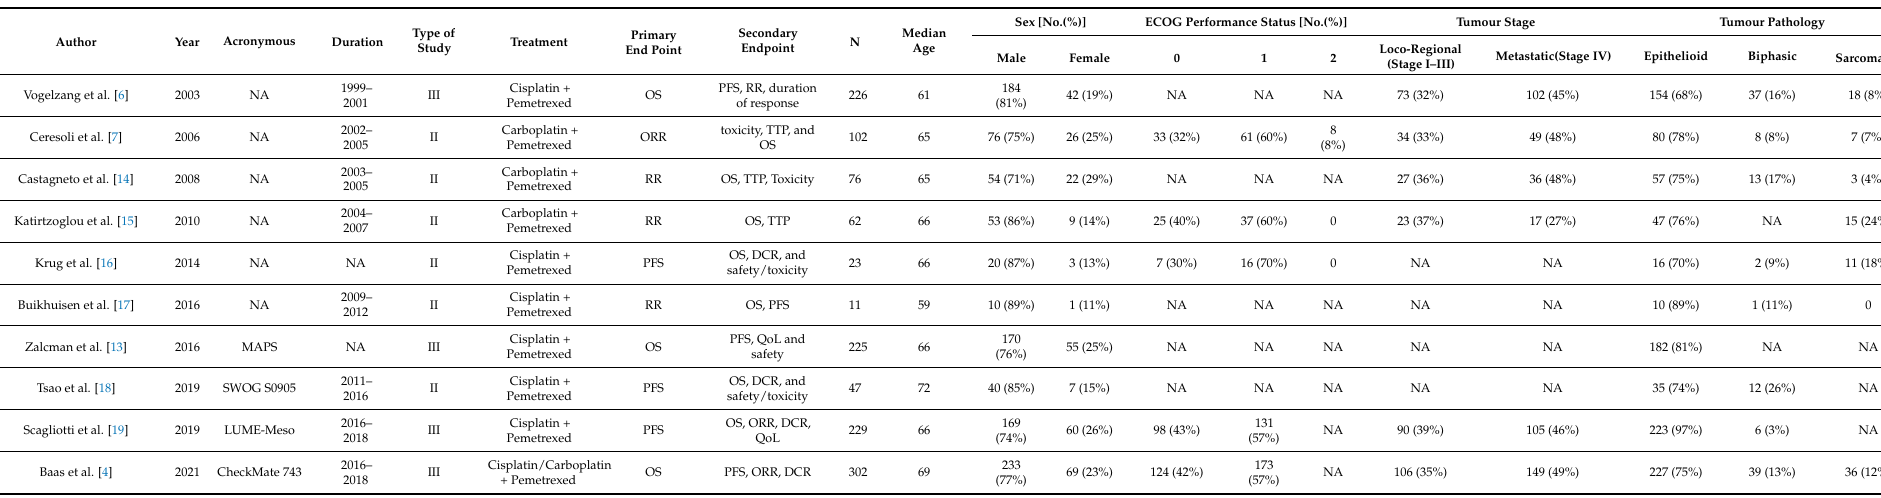
Table 1. Demographic data of malignant pleural mesothelioma patients treated with cisplatin/carboplatin and